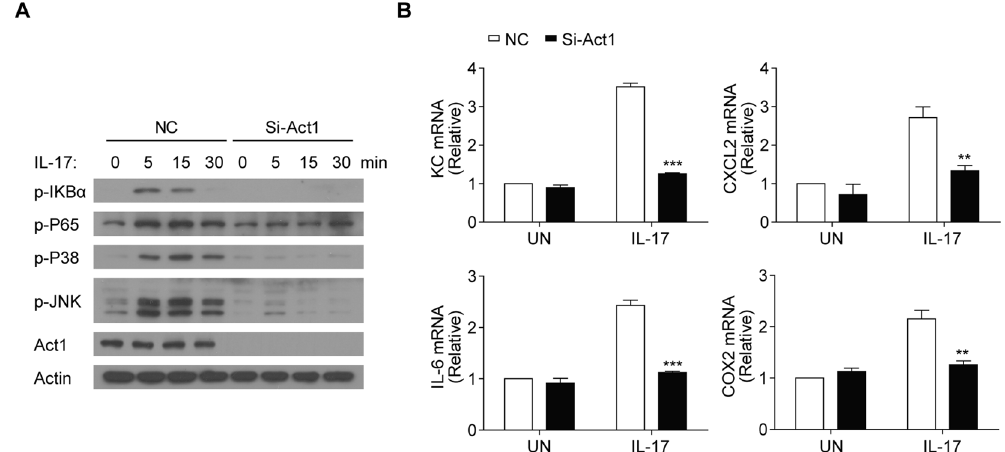
Figure 5. Act1 is required for IL-17 signaling in FLS cells. ( A ) Western blot analysis of phosphorylated (p-) or total proteins with the indicated antibodies in lysates of human primary FLS cells infected with control virus (NC) or the virus for Act1-specific siRNA (Si-Act1) and then left untreated (0) or treated for the indicated time points with IL-17 (50 ng/ml). ( B ) Quantitative mRNA expression of KC, CXCL2, IL-6 and COX-2 in the FLS cells infected as in ( A ) and then left untreated (0) or treated for 1 hr with IL-17 (50 ng/ml). Data are representative of three independent experiments (mean and s.e.m. in B ). ** P < 0.01, *** P < 0.001 by Student’s t test.